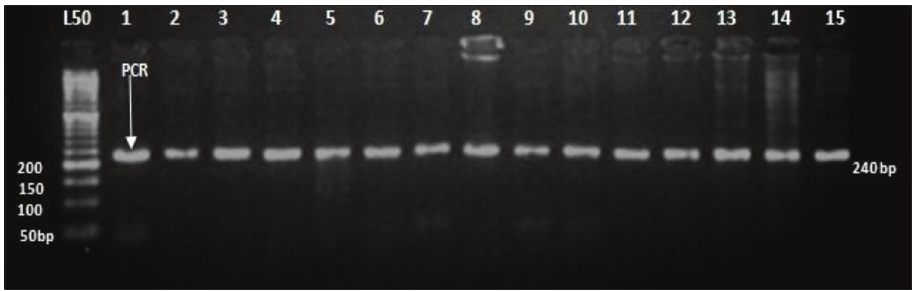
Figure-4: Agarose gel electrophoresis (4%) displaying SpeI /digest on an amplified product of Watish BMP15-FecX H in exon2. Lane 1: Polymerase chain reaction product. Lanes 2-15: Represent ++ 240 bp. Lane L: 100 bp DNA Ladder.